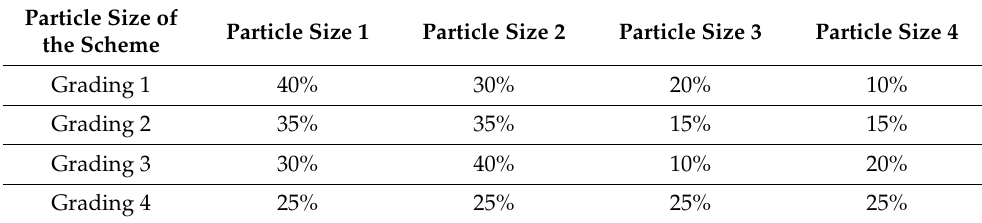
Table 1. Aggregate grading